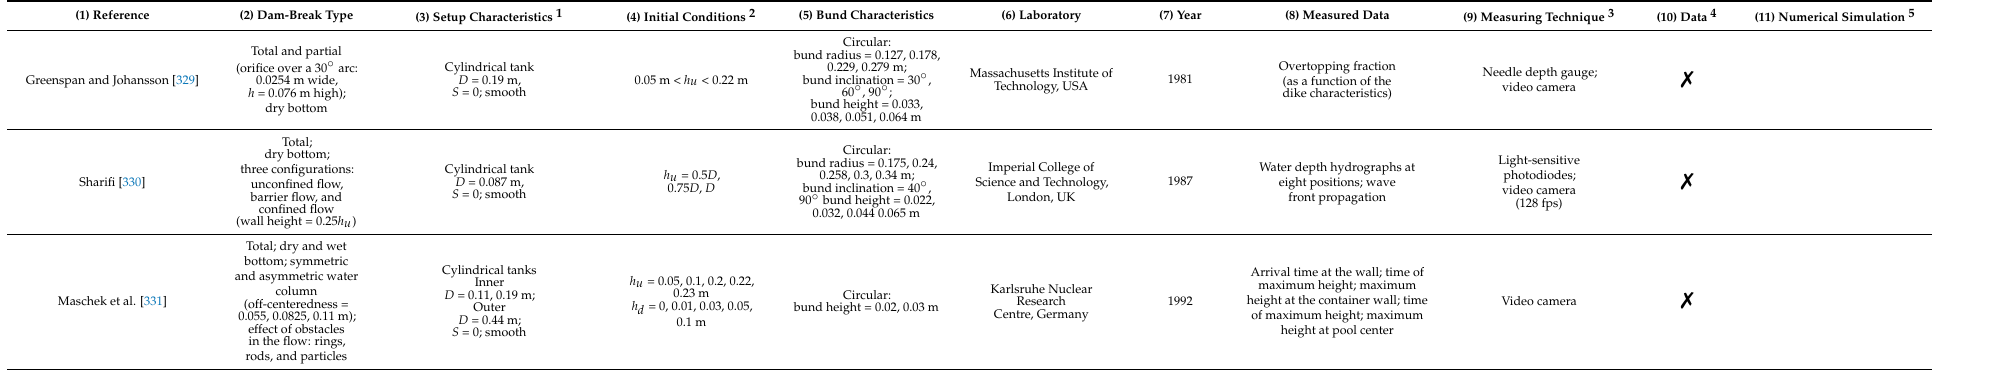
Table 10. Experimental investigations of collapses of storage tanks and bunds or dike overtopping.